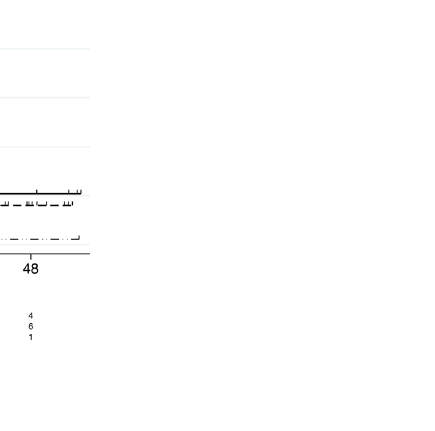
FIGURE 4 | Kaplan – Meier curves for overall survival strati fi ed according to LIPI score. Median OS for poor, intermediate and good LIPI was 2.1 months, 6.4 months, and 9.8 months,